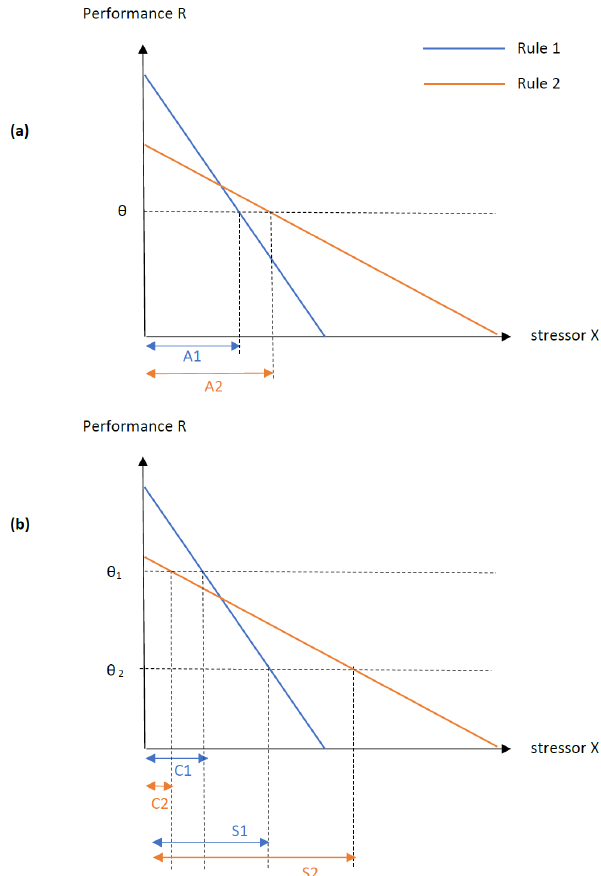
Figure 3. The case of different performance slopes, as a function of a single stressor X . (a) With a crisp threshold θ , Rule 2 has a larger acceptable region A2. (b) With a fuzzy threshold ( θ 1 , θ 2 ), the fuzzy set of acceptable outcomes over performance R has a core ( R ≥ θ 1 , where acceptability is µ = 1) and a support ( R ≥ θ 2 , where µ ≥ 0), to which respective regions C and S are associated. Rule 2 has a larger domain S2 where acceptability is at least partial but a smaller full acceptability domain C2 than Rule